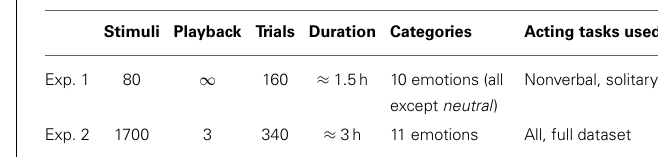
Table 3 | Experiment